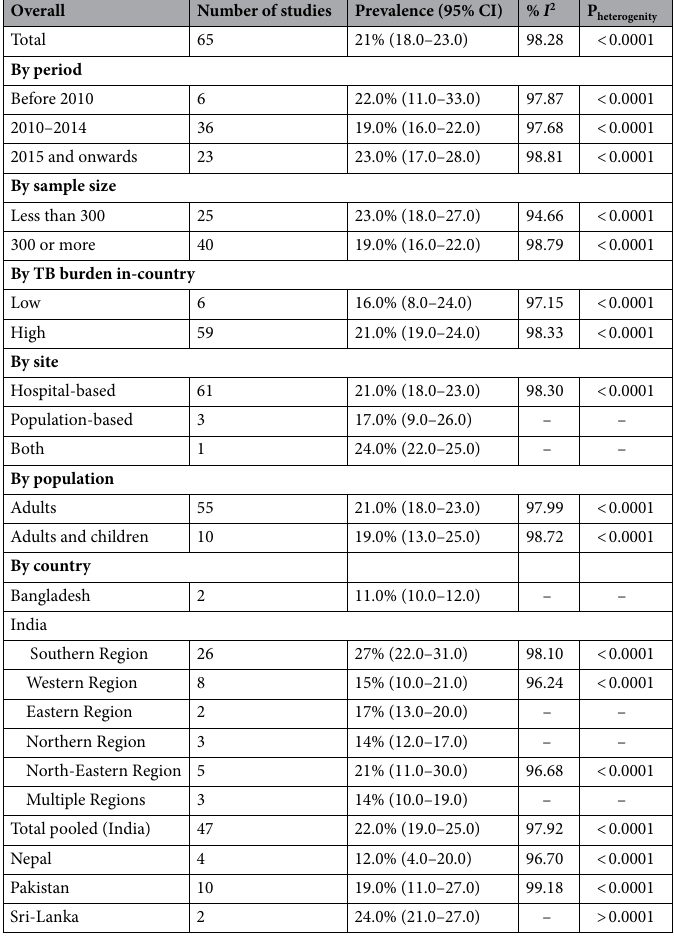
Table 1. Subgroup analysis of the prevalence of diabetes in people with